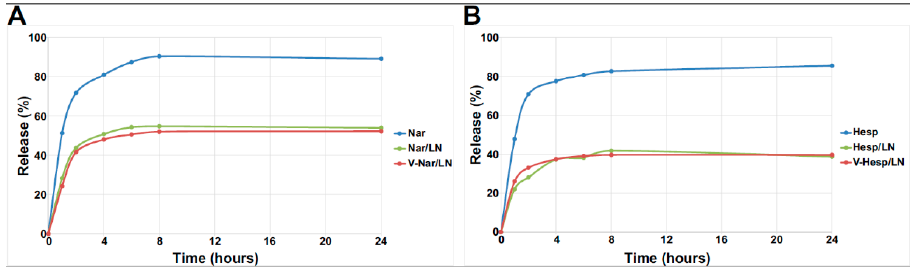
Figure 2. In vitro cumulative release (%) of naringenin ( A ) and hesperetin ( B ) from non-targeted and VCAM-1 targeted LNs or free flavonoids in Phosphate Buffered Saline (PBS), pH 7.4 at 37 °C.